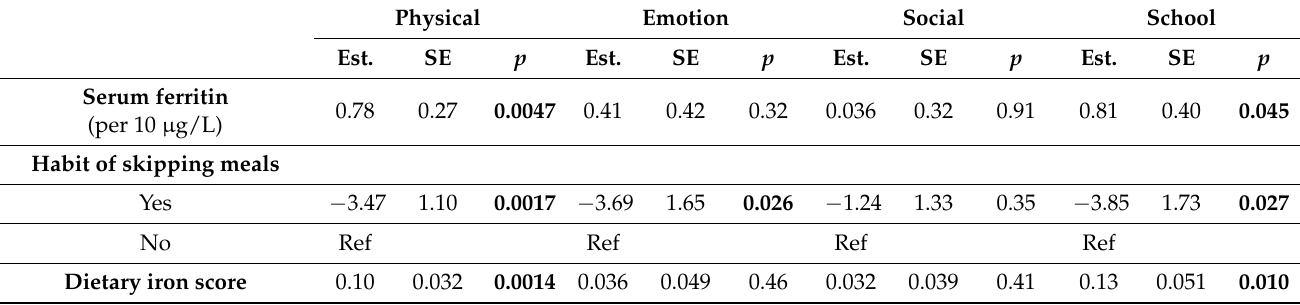
Table 4. Factors associated with quality of life and fatigue